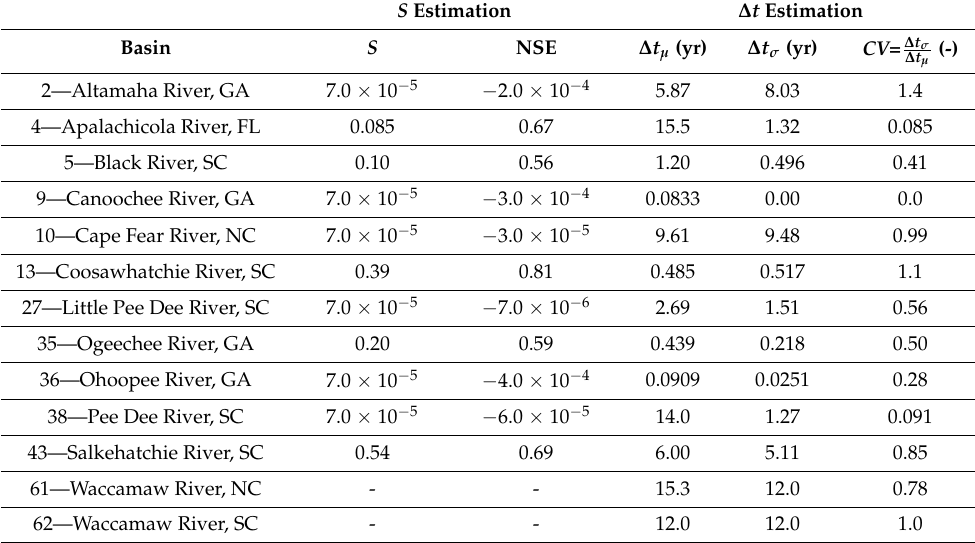
Table 1. Estimations of ∆ t and S produced from the methodology used in this work for the 13 basins without evidence of saltwater presence. The symbols ∆ t µ and ∆ t σ are mean time lag and standard deviation of estimated time lags,